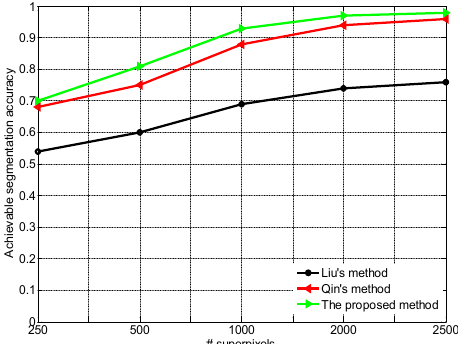
Fig. 6. Achievable segmentation accuracy (ASA) of three methods with different superpixel